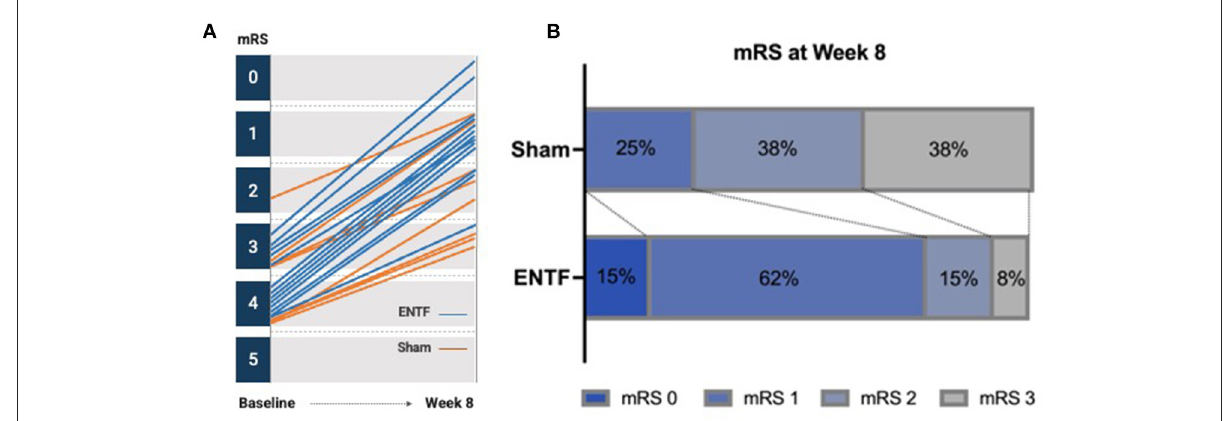
FIGURE4 Change in modified Rankin Scale (mRS) from baseline to week 8. (A) Individual participant trajectories from baseline to week 8, yielding greater group reduction in disability severity in the ENTF compared to sham group, − 2.5 ± 0.7 vs. − 1.3 ± 0.5, p = 0.0005. (B) Distribution of final mRS scores at week 8, with more favorable outcomes evident in ENTF vs. sham